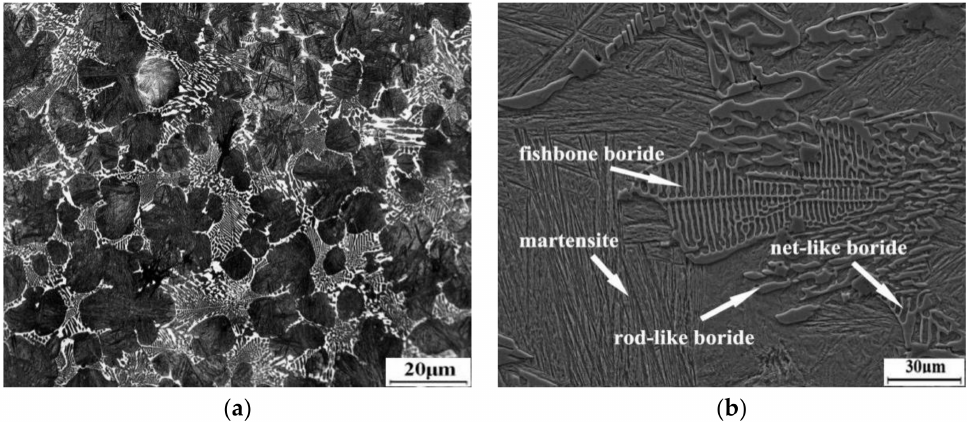
Figure 3. As-cast microstructure of experimental steel: ( a ) OM micrography and ( b ) SEM microgra-